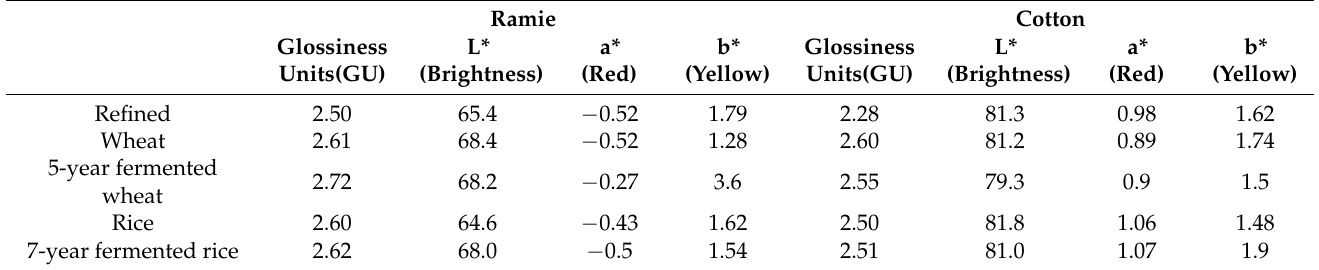
Table 4. Glossiness and brightness of fresh wheat starch, 5-year fermented wheat starch, fresh rice starch and 7-year fermented rice starch.